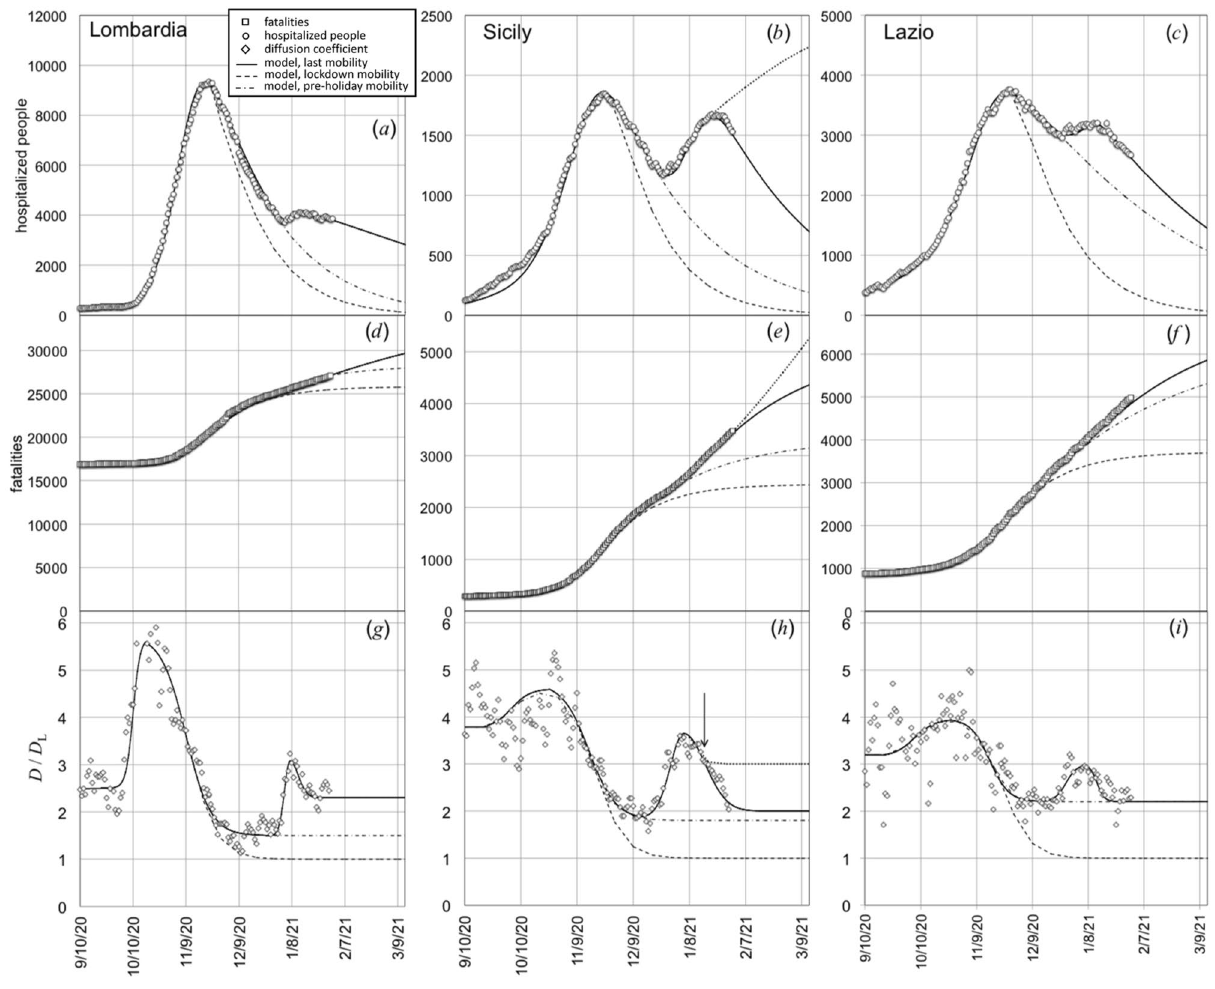
Figure 5. ( a – c ) Hospitalized cases in the time range that includes holyday season 2020, in Lombardia, Sicily, and Lazio, respectively. ( d – f ) Corresponding number of fatalities. ( g – i ) Values of the diffusion coefficient normalized to D L Easing of restrictions during holiday season increased the diffusion coefficient, with peaks centered on January the 5th, 2021. Continuous lines fit the present model to the data. Dashed lines correspond to the decrease of D , after October the 20th, 2020, to D L . Dot-dashed lines describe the situation we would have expected if restrictions had maintained unchanged during holiday season. For Sicily, the simulation of a post- peak holiday season diffusion coefficient that decreases to a level as large as 3 times than D L is shown (dotted The variation of D / D L around the peak of holiday season has not been the same among the different Italian Regions. This is shown in Fig. 5 for Lombardia, Sicily, and Lazio. We notice that only Lazio has returned to a situation with a diffusion coefficient of the pre-holiday season value. Conversely, the ratio D / D L in Lombardia approached the value of 2.3, significantly larger than the pre-holiday season value ( D / D L = 1.5). Sicily has expe- rienced the most critical situation, with D / D L that has reached, during holiday season, a peak value as large as 3.6, thus triggering the start of a third wave of the outbreak, well visible in the plot of hospitalized cases shown in Fig. 5b. Indeed, beyond the holiday season peak, the ratio D / D L for Sicily has exhibited a relatively slow decreasing rate and, on January the 15th [see the arrow in Fig. 5h], it was still at a level of about 3.3. In particular, dotted lines in Fig. 5b, e, h show the results of our simulation under the hypothesis that D / D L for Sicily had approached, after the holiday season peak, a constant value equal to 3. With this assumption a new wave of the virus epidemic in the Region would occur. On January the 15th, however, the Italian Government imposed for Sicily more severe mobility restrictions (“red zone”), inducing a further decrease of D/D L and, as a consequence, the number of hospitalized people decreased as well (Fig. 5b). In this first part of the discussion, we have presented the capability of the model to evaluate D and to compare its value to the different restriction levels in Italy: before, during and immediately after lockdown, during and after summer, during and after holidays. In brief, we have related all the restriction levels to corresponding D -values in a quite direct relation. This gives us, as shown in Figs. 2, 3, 4, 5, the possibility of forecast the dynamics of the disease holding the restrictions or modifying them. Some SIR-based models simulated the lockdown dynamics by